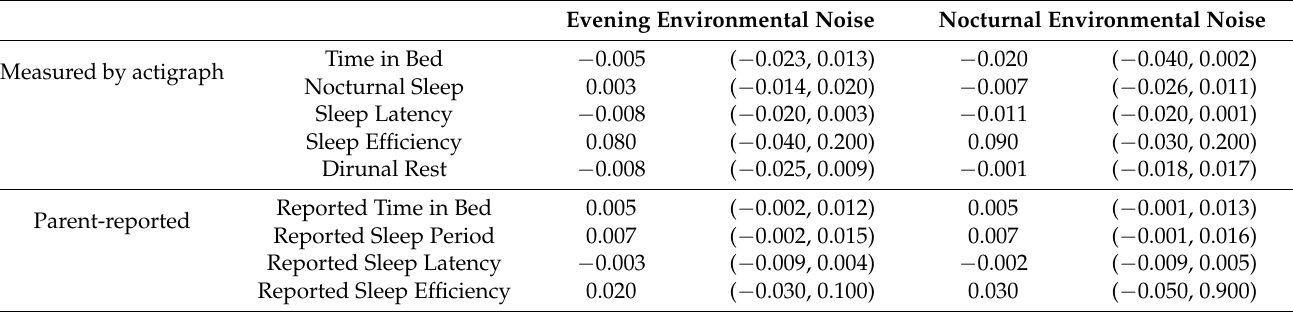
Table 3. Total effects of evening and nocturnal environmental noise on sleep habits. Non-standardised B-estimates and 95% confidence intervals (in parenthesis) are